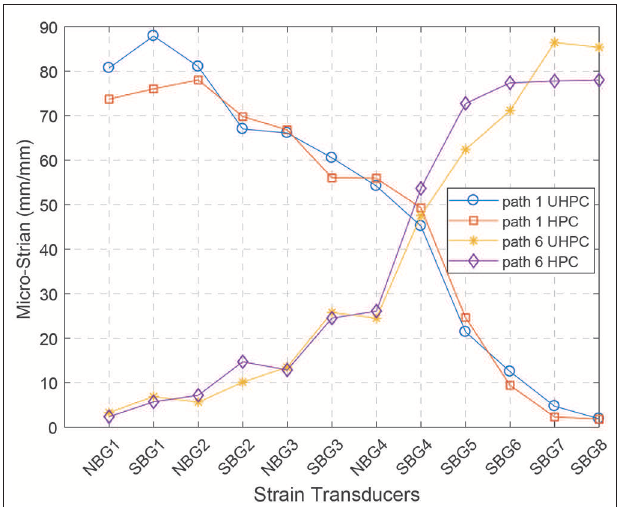
FIGURE 6 | Strain measurement for paths 1 and 6.